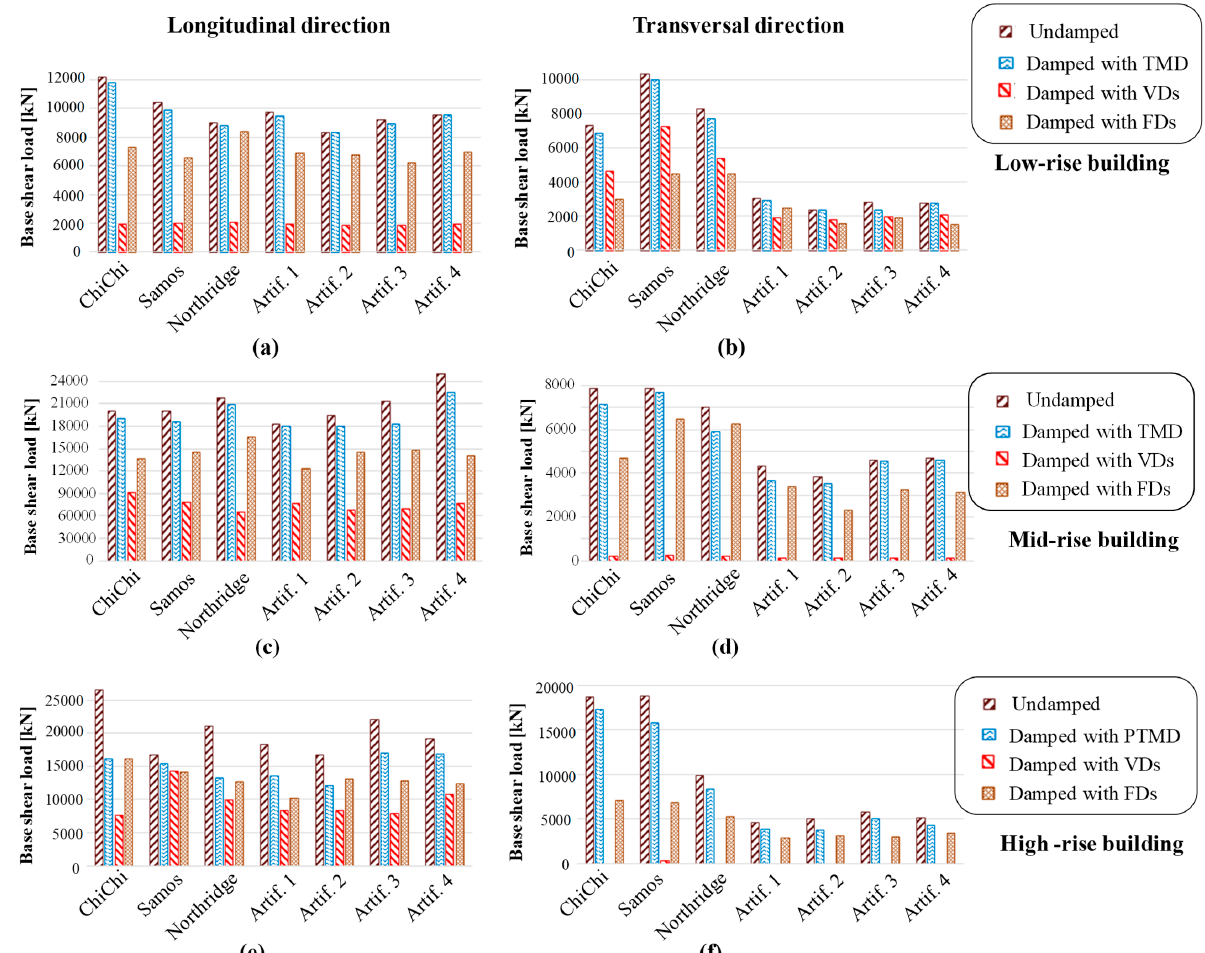
Figure 13. Base shear load for ( a , b ) the low-rise building, ( c , d ) the mid-rise building and ( e , f ) the high-rise building.